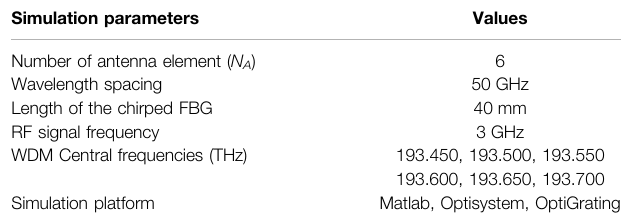
TABLE 1 | Simulation parameters.